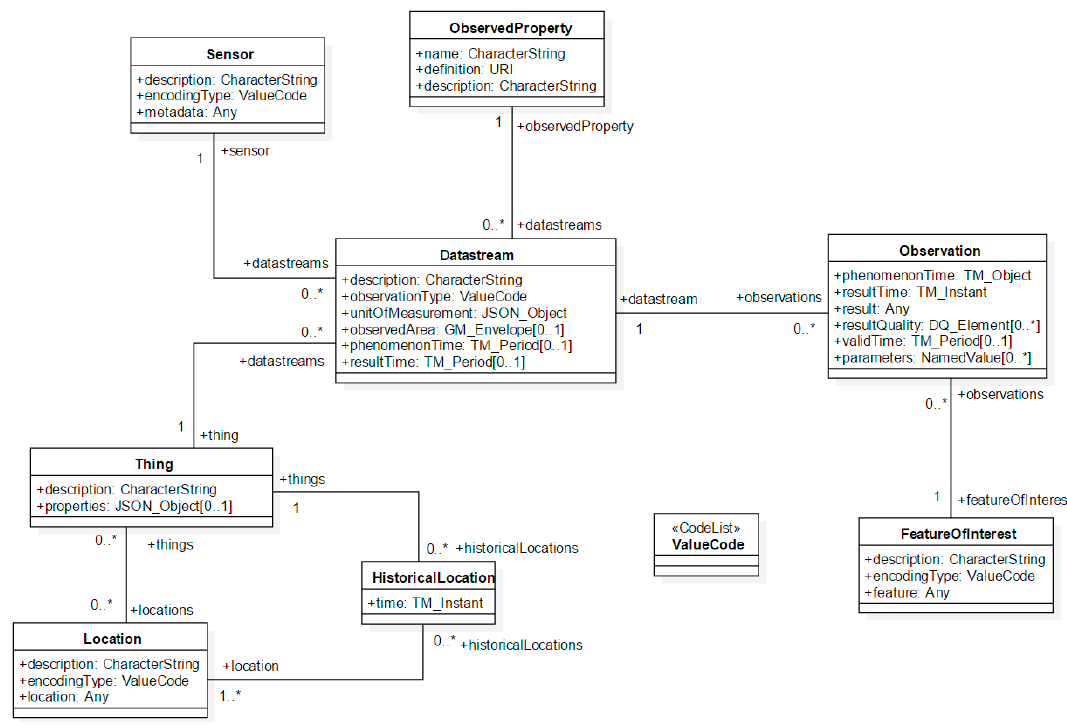
Figure 3. The data model of the OGC SensorThings API [10].